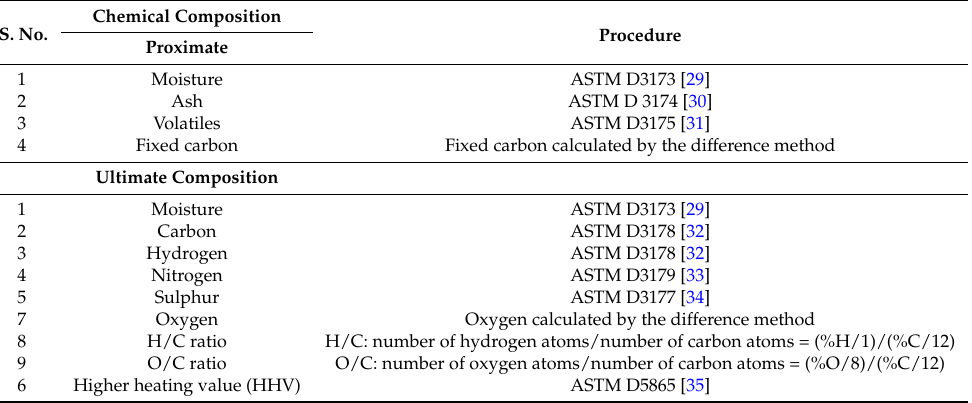
Table 1. Methods to measure the chemical properties and higher heating values.